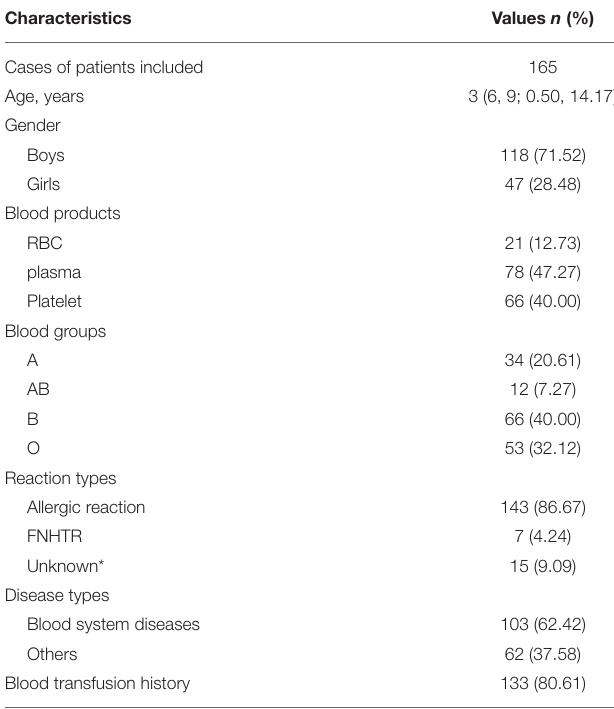
TABLE 1 | Baseline information of pediatric patients with transfusion